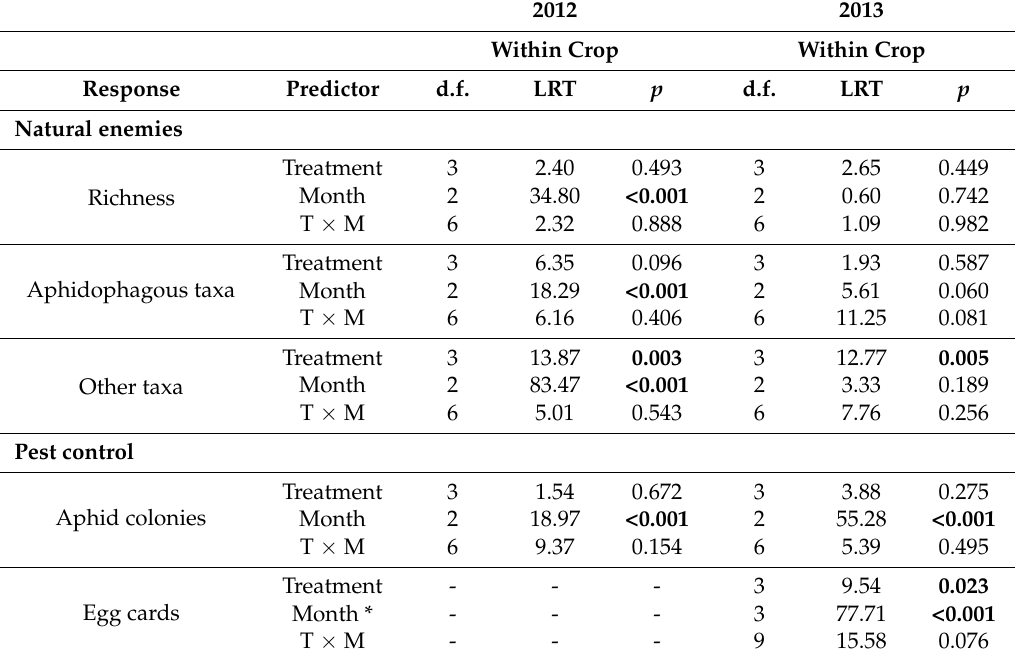
Table 2. Summary of minimum adequate models selected by inference on likelihood ratio tests. Effects of treatment (factor with four levels: control, concealed-nectar mix, mixed plots, and open-nectar mix), sampling month (factor with three levels *: June, July and August), and the interaction between treatment (T) and month (M) on natural enemy richness, abundance of aphidophagous taxa, non-aphidophaous natural enemy taxa, aphid colony densities, and egg card predation within adjacent apple trees in each year. Arthropods sampled on ten trees (five branches per tree) per plot on five separate occasions each year in four orchards. Degrees of freedom (d.f.), test statistics (LRT) and p -values from likelihood ratio tests are shown. p -values of fixed effects included in final models are presented in bold ( p <